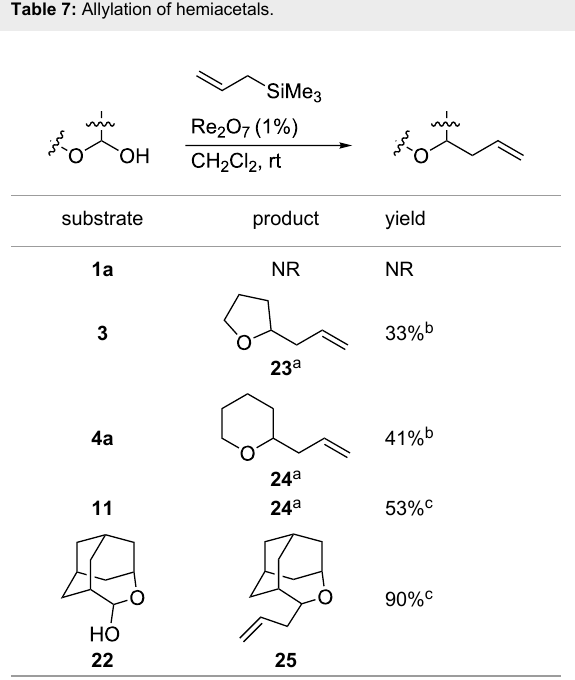
Table 7: Allylation of